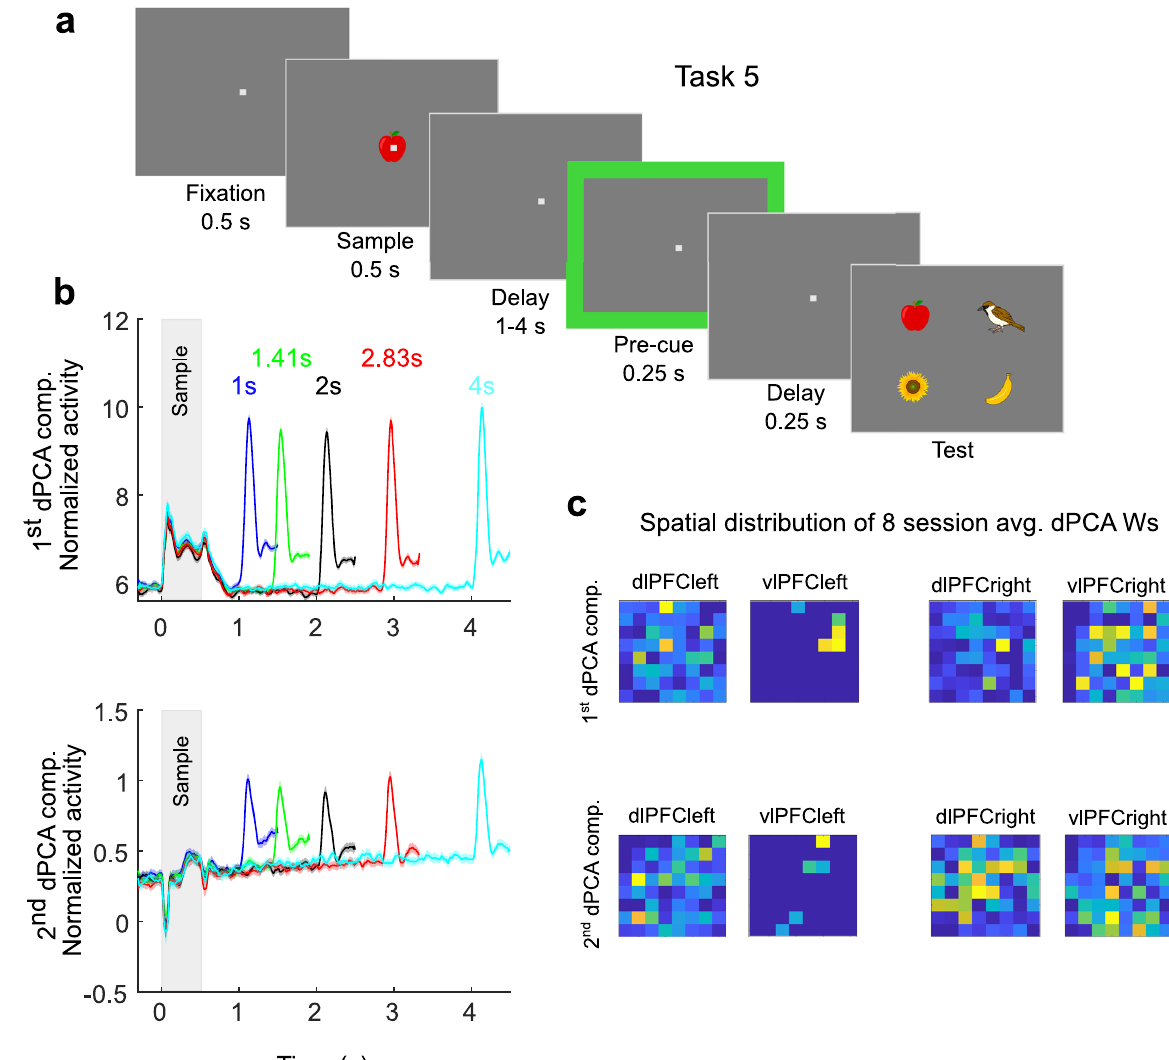
Fig. 5 | Spatial patterns of control-related activity in task with cued read-out. a Schematic depiction of the delayed match-to-sample task with read-out cue. The delay lengths were randomly drawn from 5 possible delay lengths (1, 1.41, 2, 2.83, and4s).On90%oftrials,therewasatestpre-cuesignalingtheupcomingtest.Only those trials were analysed. Recording locations same as in Task 4. b The fi rst (top) and second (bottom) task-general dPCA components of gamma activity ( n =232 electrodes). They are projected using the eight-session average dPCA weight